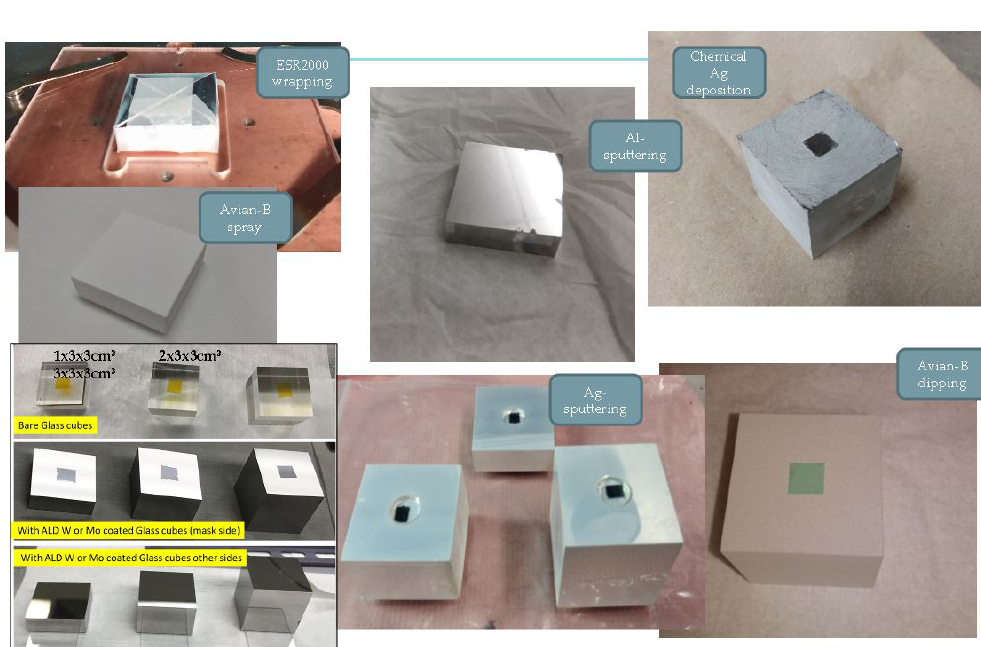
Figure 3. Sample of coated and wrapped ADRIANO2 glass tiles.